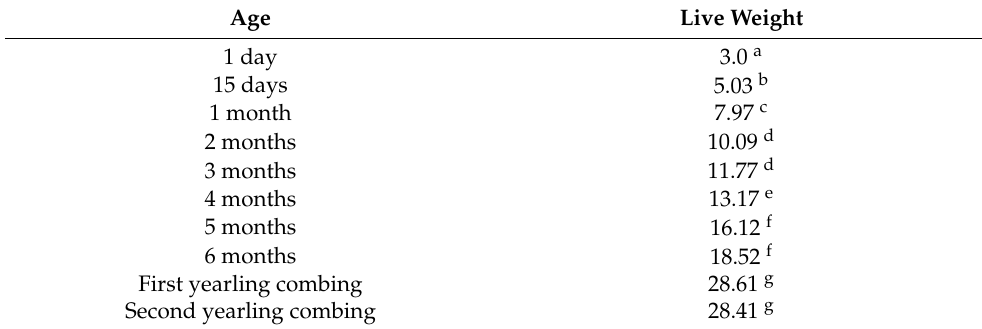
Table 3. Live weight at different time points.